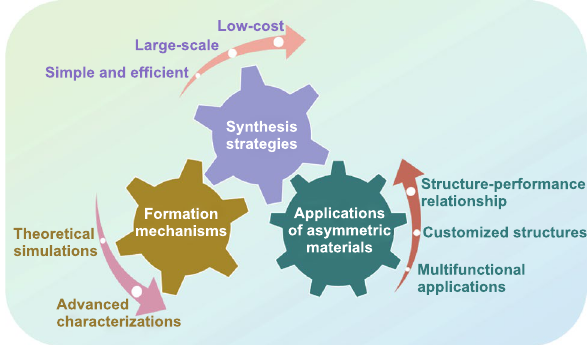
Fig. 15 The main challenges and the future development prospects of asymmetric carbon- and silica-based